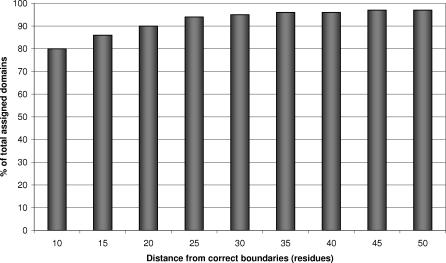
Percentage of Domain Assigned (Blue) and Percentage of Domain Boundaries within Ten Residues of Verified Boundaries (Pink) at a Range of SVM Score Cutoffs